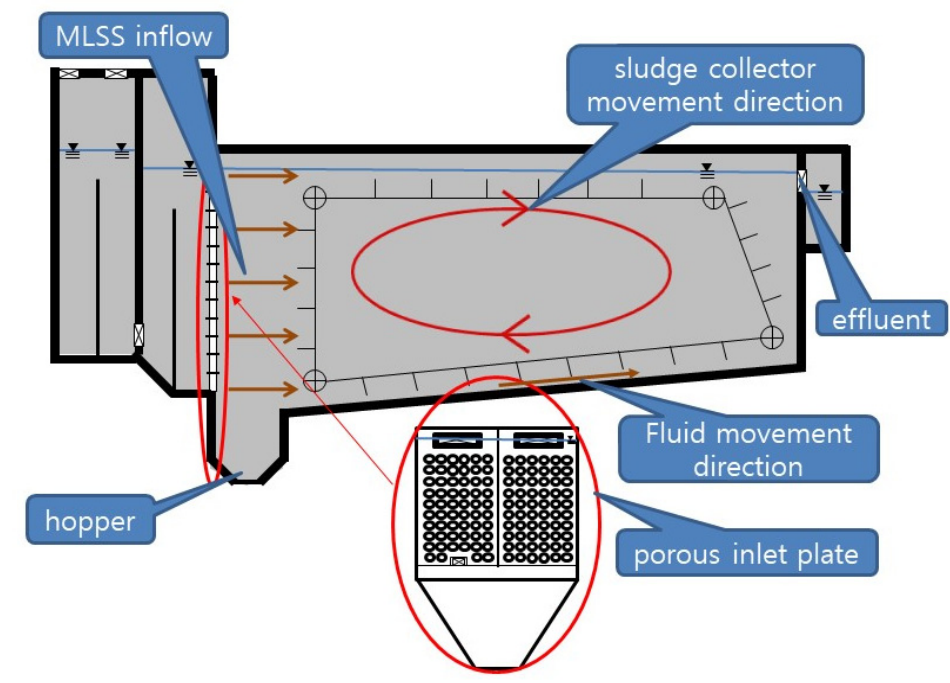
Figure 1. Longitudinal view of the secondary clarifier and porous inlet wall at plant A.